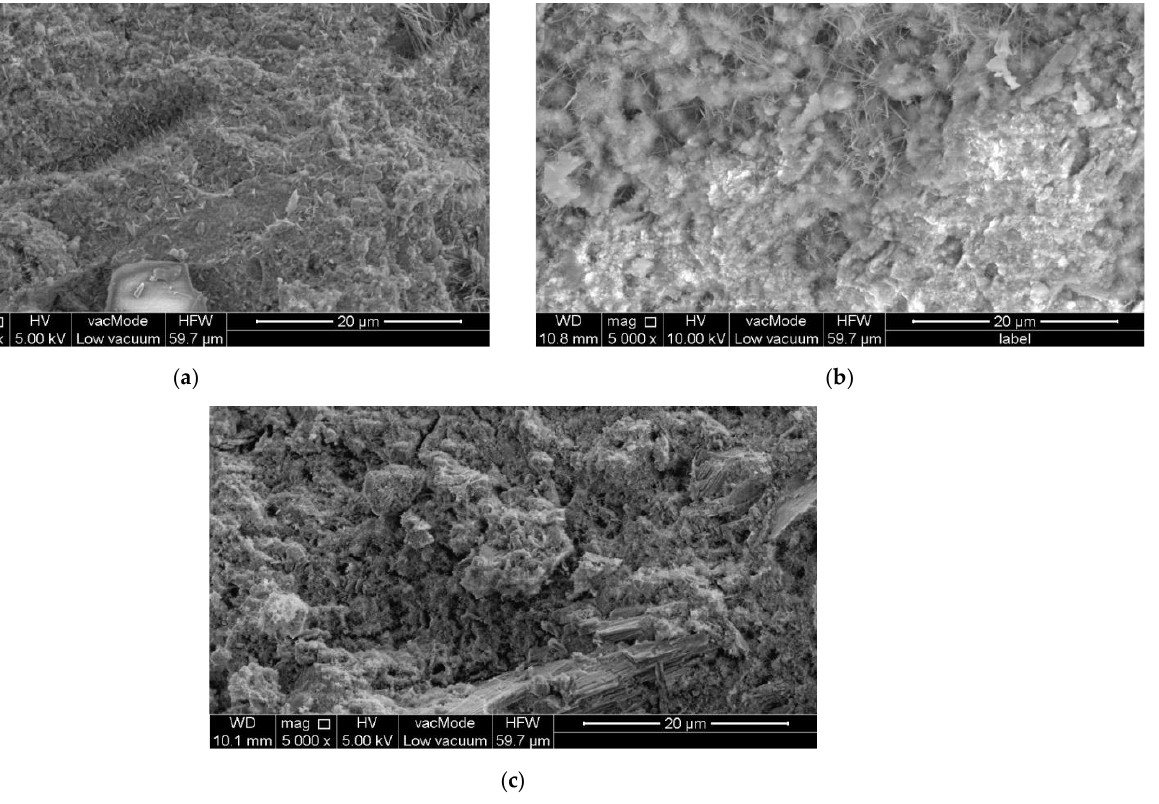
Figure 2. Images taken with a scanning electron microscope (magnification 5000×): ( a ) concrete without NC, ( b ) concrete with CNC, and ( c ) concrete with CNF (own research).